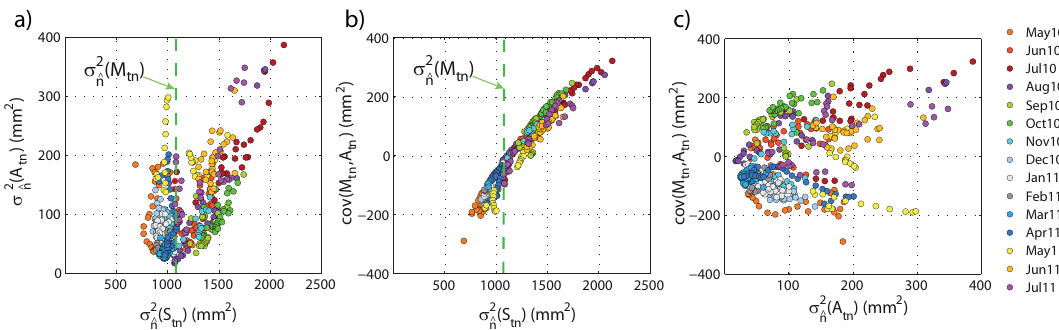
(S tn ) ) vs. spatial variance of anomalies ( σ 2 (A tn ) ), (b) spatial b n b n